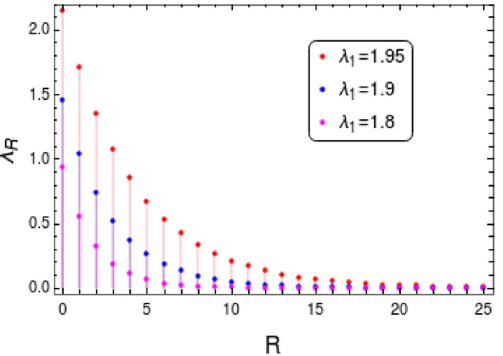
2 µ . The critical value (cid:31) 1 =